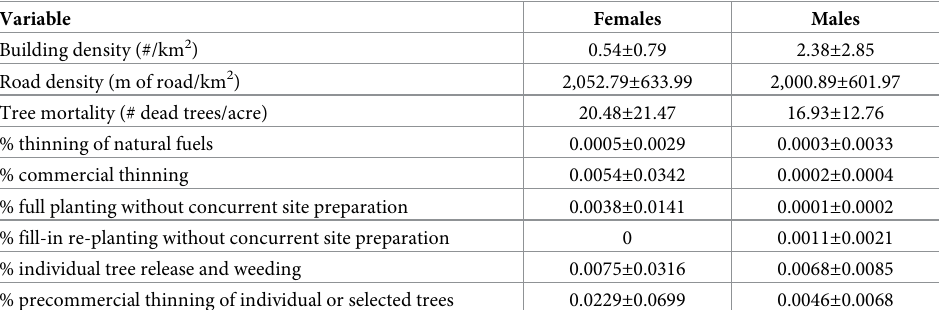
Table 1. Metrics (mean ± SD) of building density, road density, tree mortality, and percent of the home range affected by management activities in the 95% kernel home ranges of female and male fishers, Sierra National For- est, California,